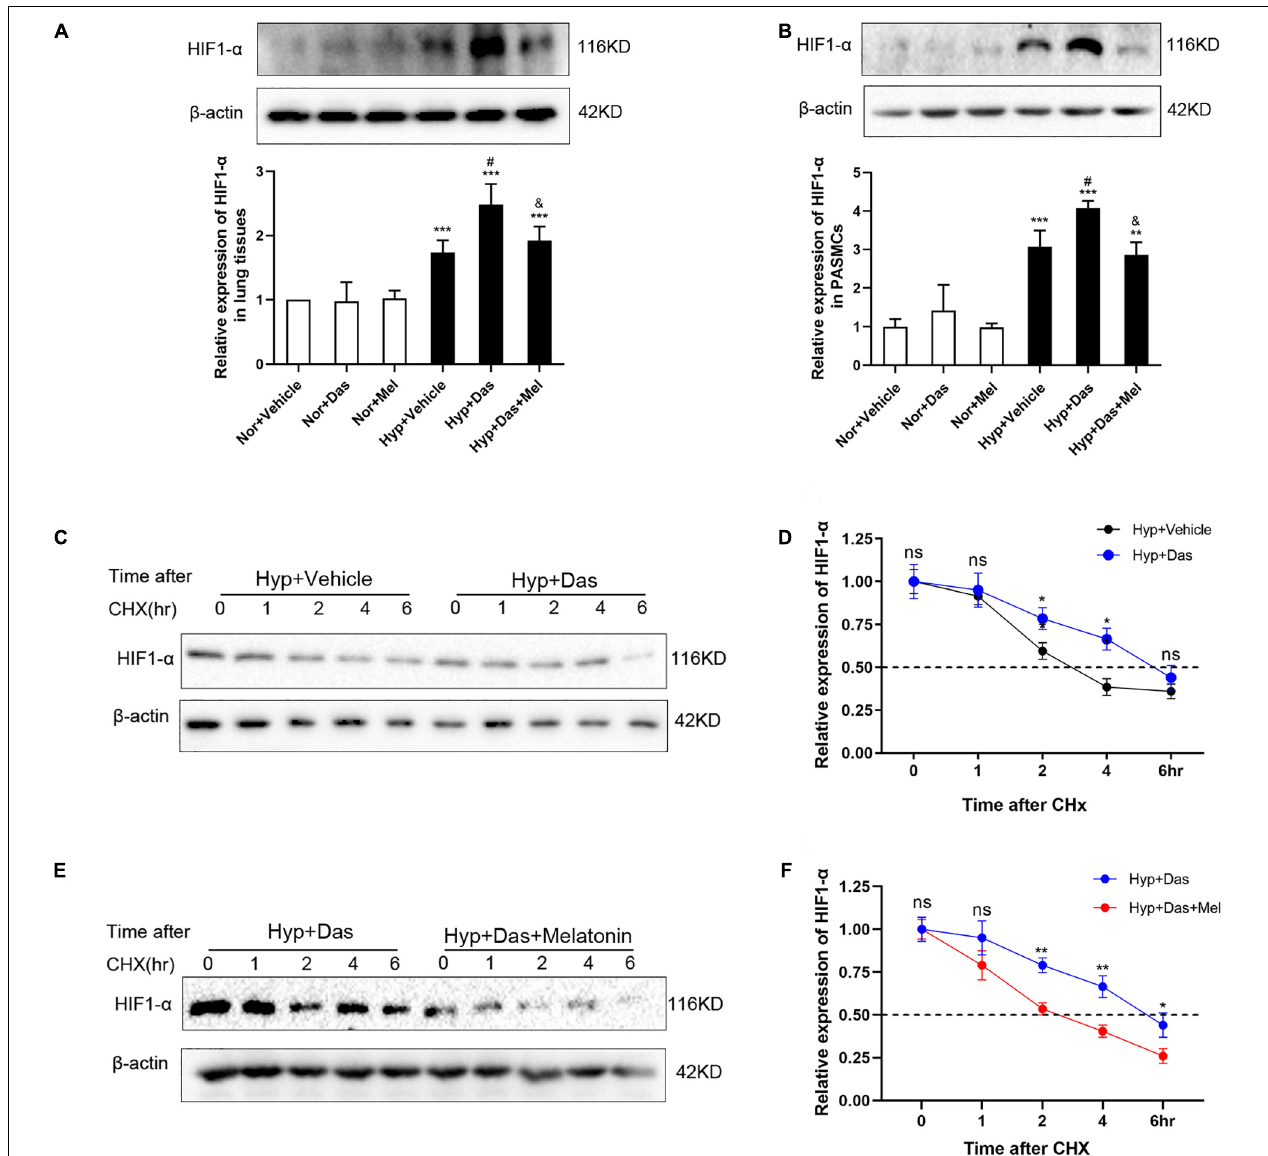
FIGURE 10 | Melatonin repressed HIF1- α protein expression induced by dasatinib under hypoxia. Protein expression of HIF1- α in rat lung tissues (A) . Protein expression of HIF1- α in PASMCs (B) . Values are means ± SEM, ***P < 0.001, **P < 0.01 compared with Nor + Vehicle group. # P < 0.05 compared with Hyp + Vehicle group. & P < 0.05 compared with Hyp + Das group. PASMCs are exposed to dasatinib or vehicle (C,D) , dasatinib or dasatinib with melatonin (E,F) under hypoxia treatment for 24 h before the addition of cycloheximide (12.5 µ g/mL). Lysates were harvested at the indicated time points, HIF-1 α expression was monitored by Western blotting, and densitometry was used to determine the rate of decay. Values are means ± SEM, **P < 0.01, *P < 0.05, ns indicates non-significant ( n =